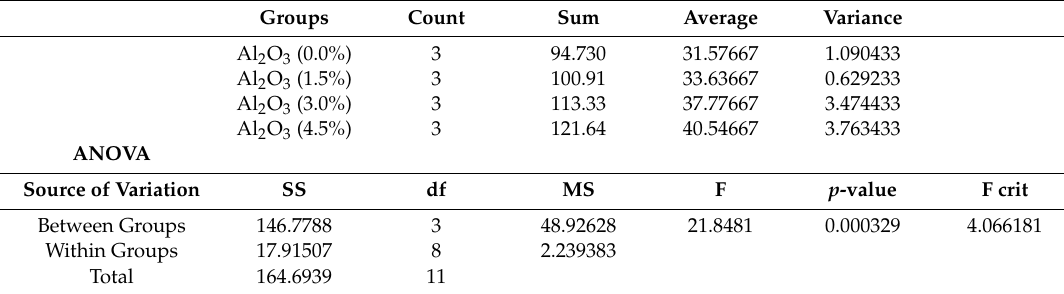
Table 5. MOR values of Al 2 O 3 -UF MDF for various treatments.